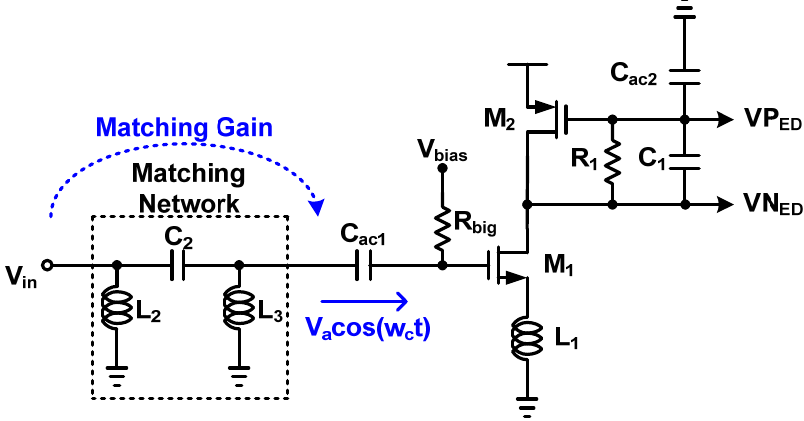
Figure 2. Conventional RF envelope detector.